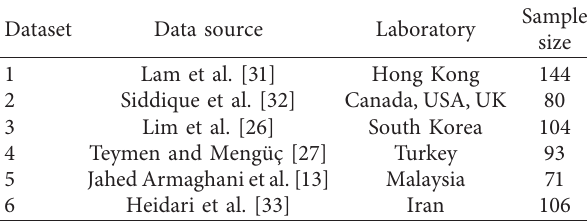
Table 1: Sources of datasets in the